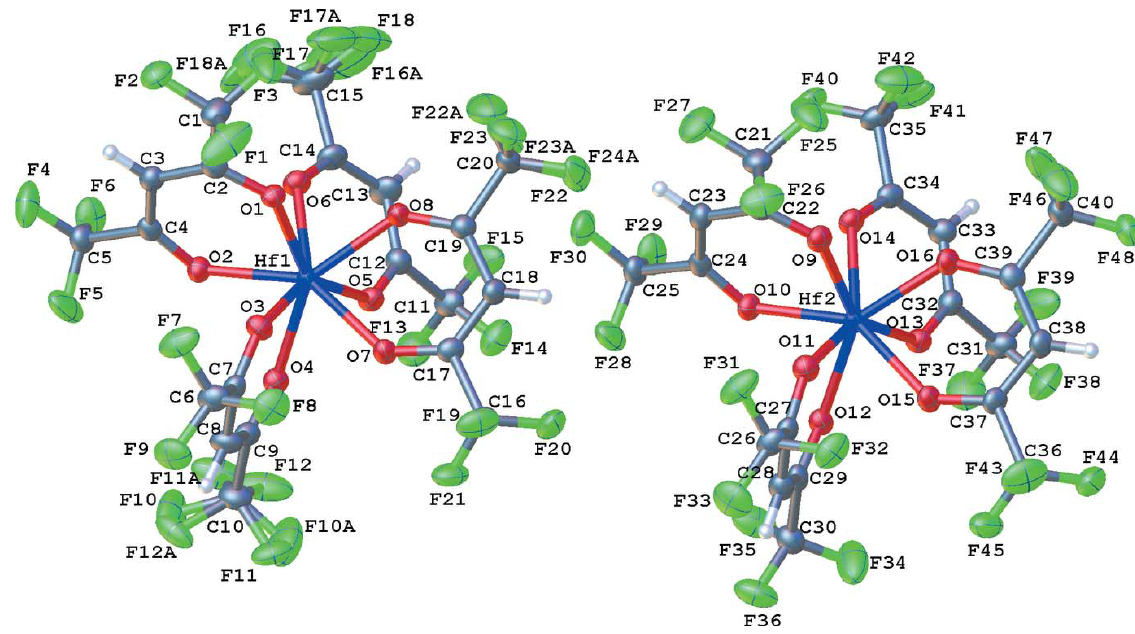
Figure 1 The asymmetric unit of Hf(hfac) 4 with displacement ellipsoids drawn at the 50% probability level. F10 A –F12 A , F16 A –F18 A and F22 A –F24 A are the minor components of the F atoms of the disordered CF 3 groups in the Hf1 molecule. Color coding: C – grey, O – red, H – white, F– green, Hf – blue.